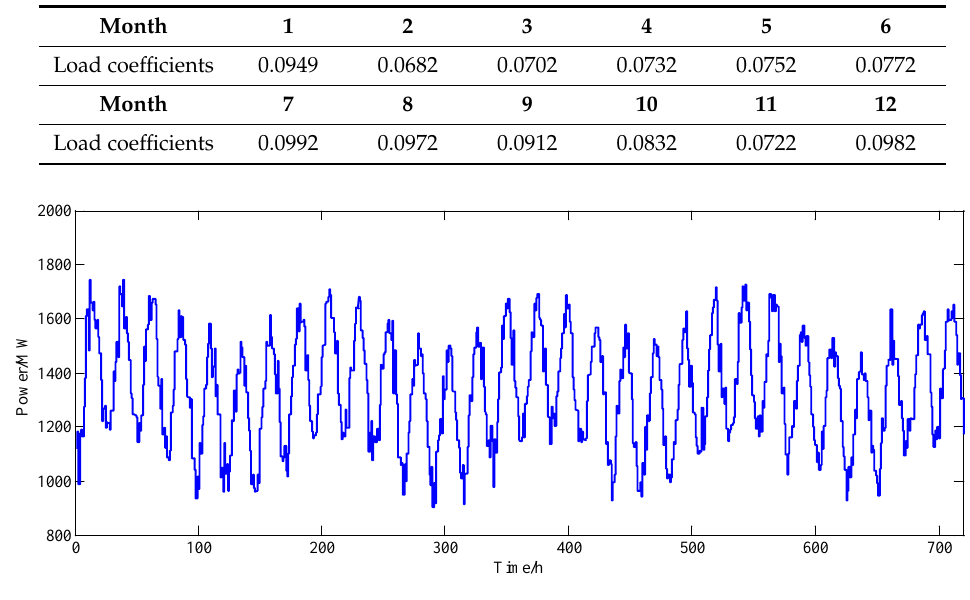
Figure 5. The load curve in April.